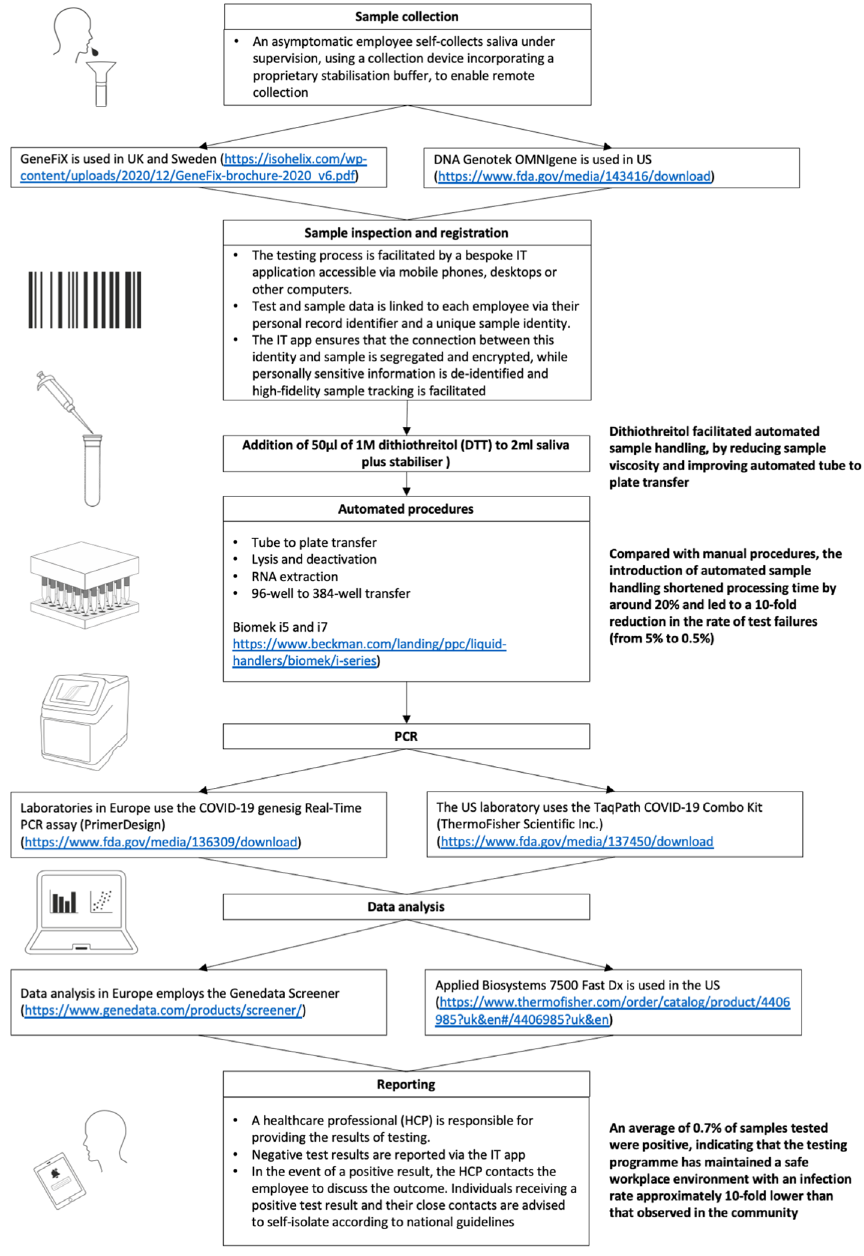
Figure 1. Overview of the automated workflow for SARS-CoV-2 testing of asymptomatic employees. Saliva samples are tested at one of three AstraZeneca laboratories: in Cambridge (UK), Gothenburg (Sweden) or Gaithersburg, MD (USA). The workflow was risk assessed and follows government guidance enabling the experimentation to be conducted at biosafety level 2 (BSL2), conforming to local laboratory standards including Good Clinical Practice (GCP) and Clinical Laboratory Improvement Amendments (CLIA) as